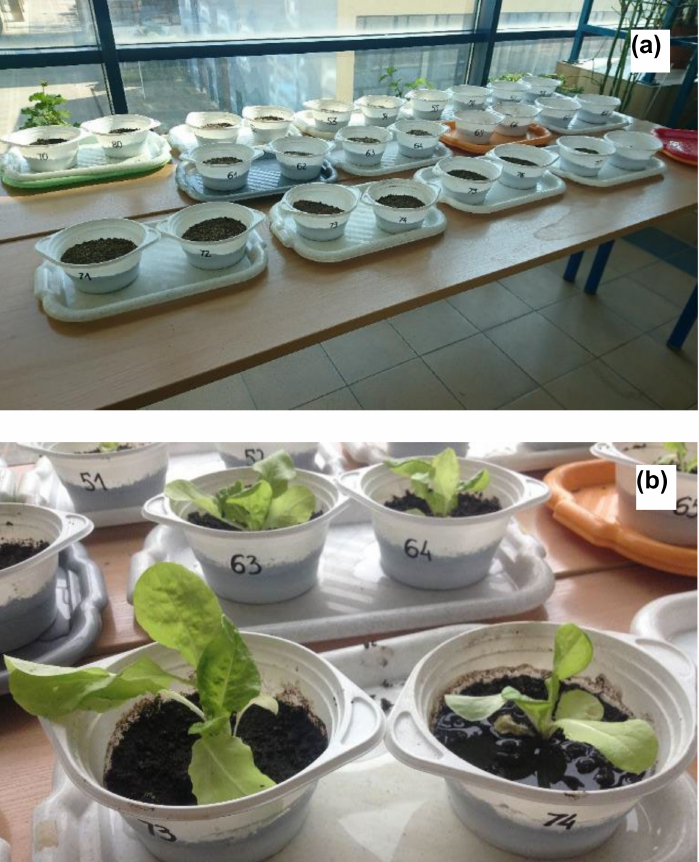
Figure 5. Vegetation experiment: ( a ) Stage 1–germination and ( b ) Stage 2–growth of lettuce ( Lactuca sativa